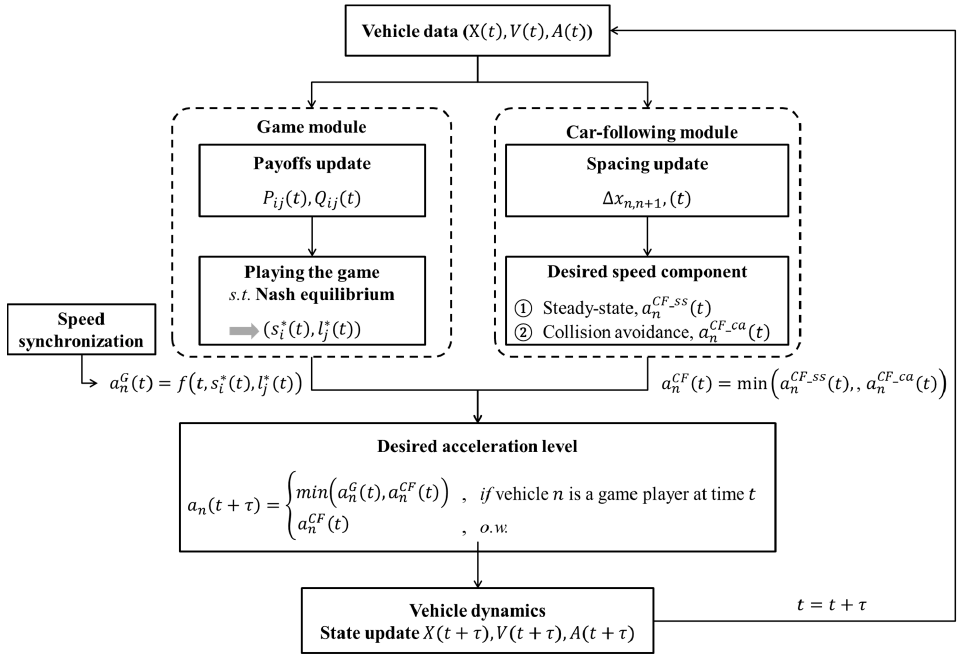
Figure 12. Vehicle acceleration controller structure in the developed simulation model.